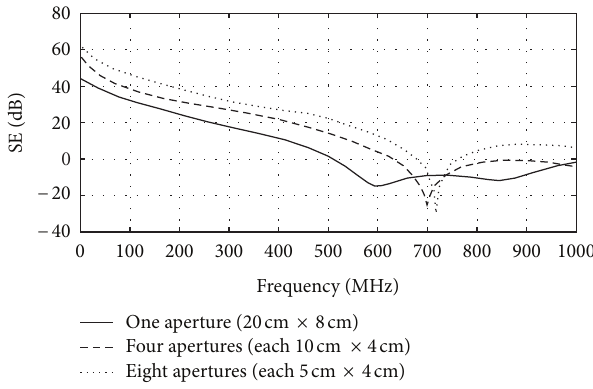
with a single slot for 12 30cm 3 × ×